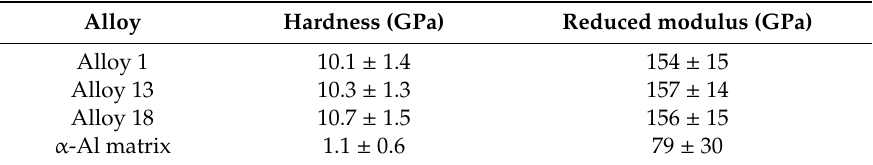
Table 3. Mechanical properties of sludge α 1 -Fe particles measured in three different experimental alloys; the values for the α -Al matrix are also given as reference.